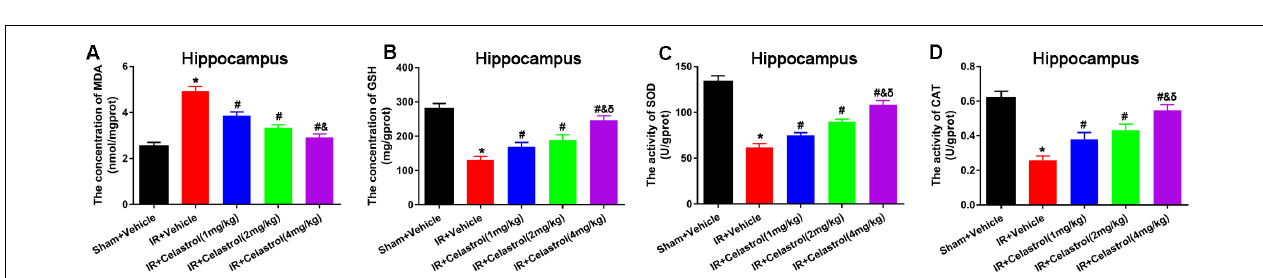
vs. 0.62 ± 0.04) were decreased in vehicle treated